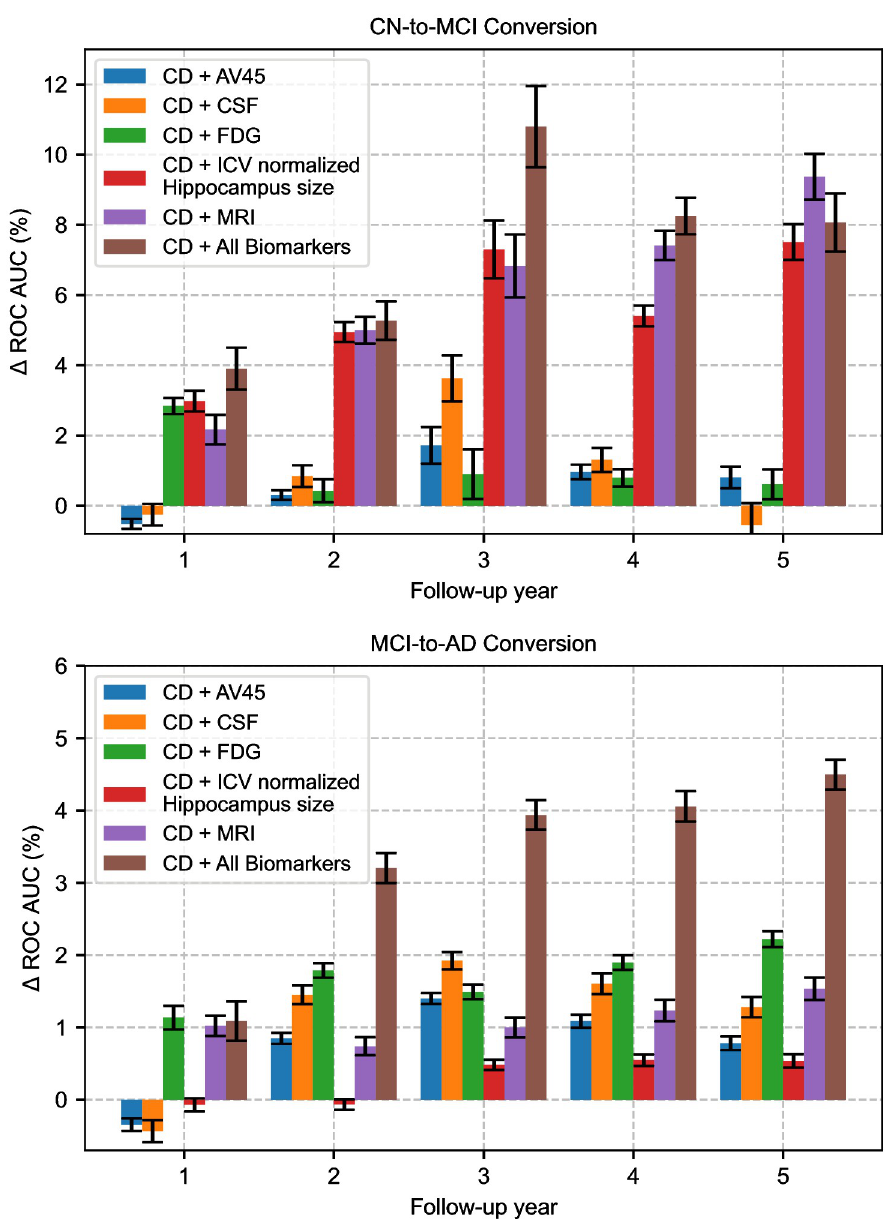
Fig 4. Δ ROC AUC values obtained with NMM by the addition of various biomarker combinations to the clinical data (participant demographics, clinical assessments, and cognitive assessments). ROC AUC values are averaged across 200 80–20 data splits. Error bars indicate the standard error across these splits. +: Used together. CD, Clinical data; AV45, Florbetapir PET; CSF, Cerebrospinal Fluid; FDG, Fluorine-18-Fluorodeoxyglucose PET; MRI, Magnetic Resonance Imaging; ICV, Intracranial